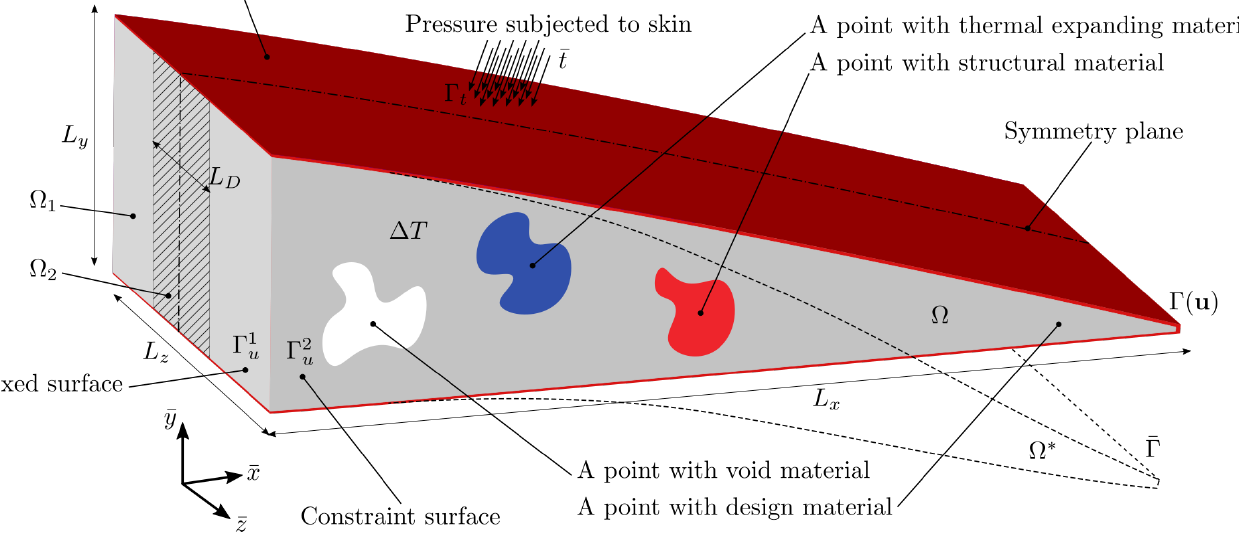
Figure 1. Design problem for the morphing trailing edge